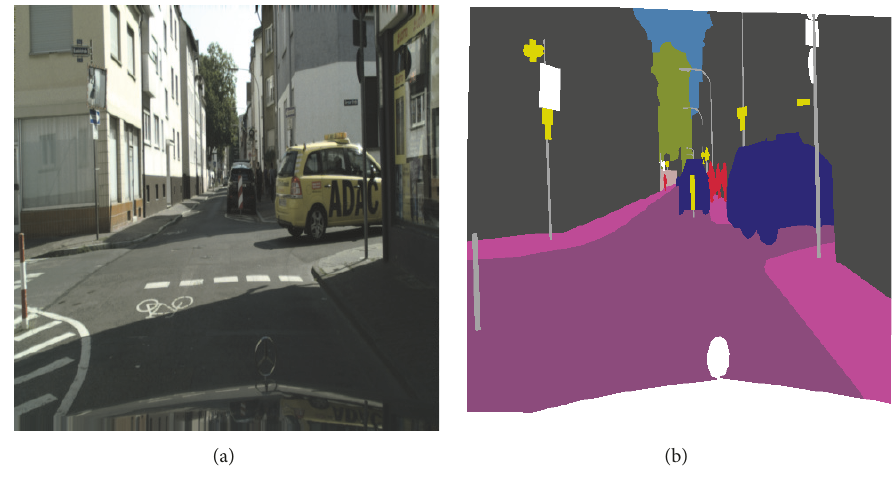
Figure 1: Examples of scene parsing: (a) image; (b) ground